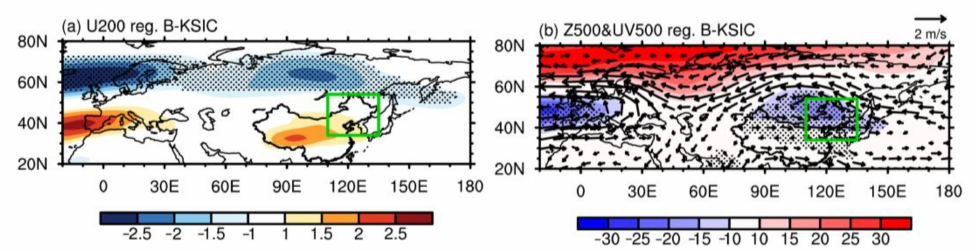
Figure 14. Linear regression of ( a ) U200 anomalies (shaded, unit: m/s), ( b ) height anomalies (shaded, unit: gpm) and wind anomalies (vector, unit: m/s) at 500 hPa on autumn B-KSIC during 1979–2015. The dotted region indicates significance at the 95% level from the t